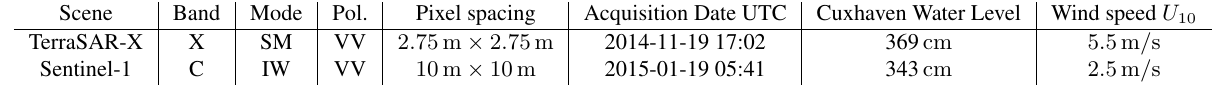
Table 1: Acquisition parameters for the presented scenes. The TS-X scene was acquired in stripmap (SM) mode while the Interfero- metric Wide Swath (IW) mode was used for the Sentinel-1